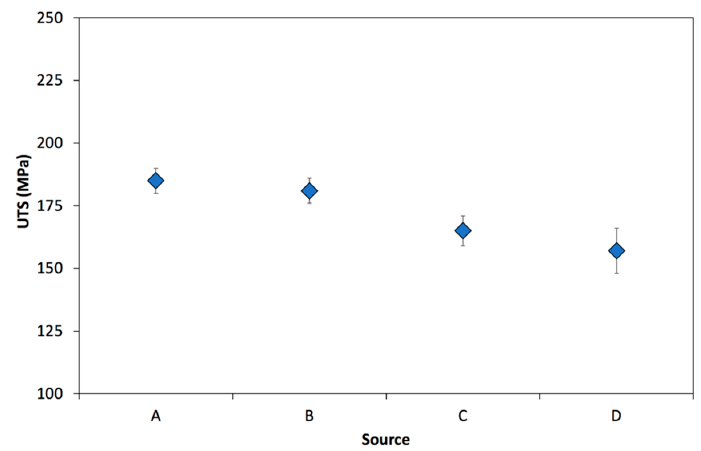
Figure 5. Change in ultimate tensile strength with source.